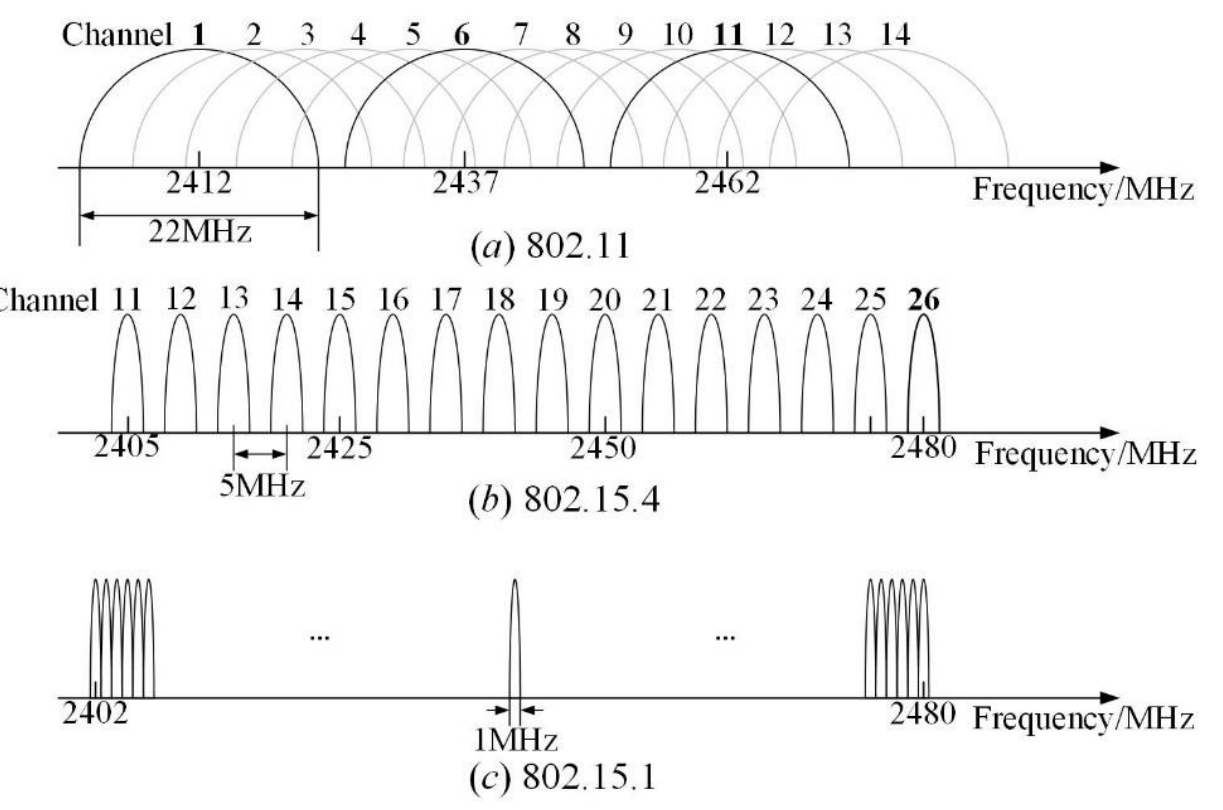
Figure 2. Channels of IEEE 802.11, IEEE 802.15.4, and IEEE 802.15.1.